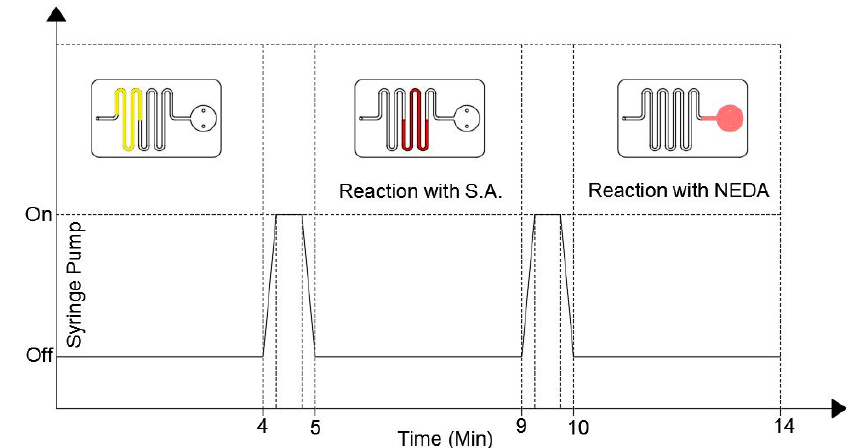
Figure 4 . The duty cycle of the syringe pump (bottom part) and the fluid position inside the microfluidic chip during the detection process.